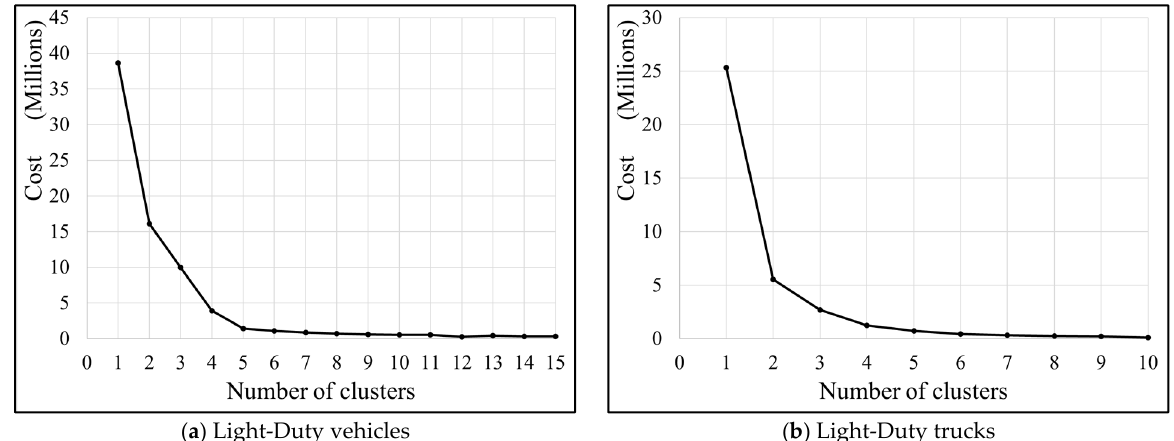
Figure 3. Determine optimal number of vehicle groups using the Elbow method.